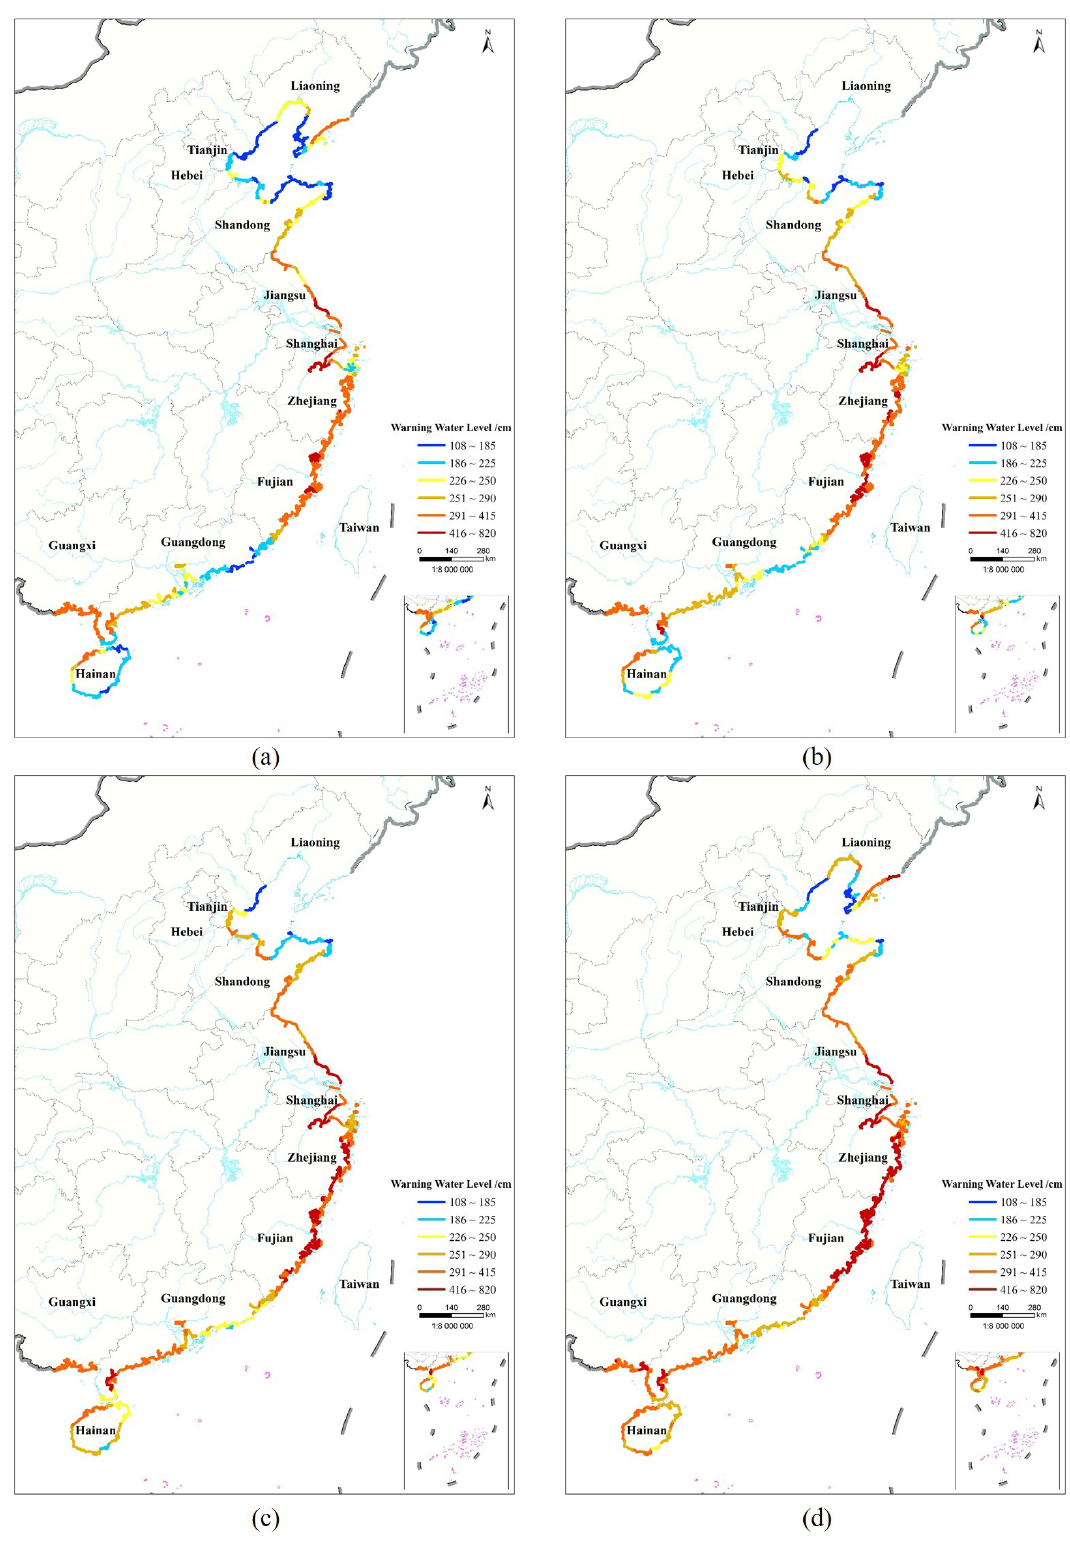
Figure 3. Spatial distribution map of the four-color warning water levels: (a) blue, (b) yellow, (c) orange, and (d) red.